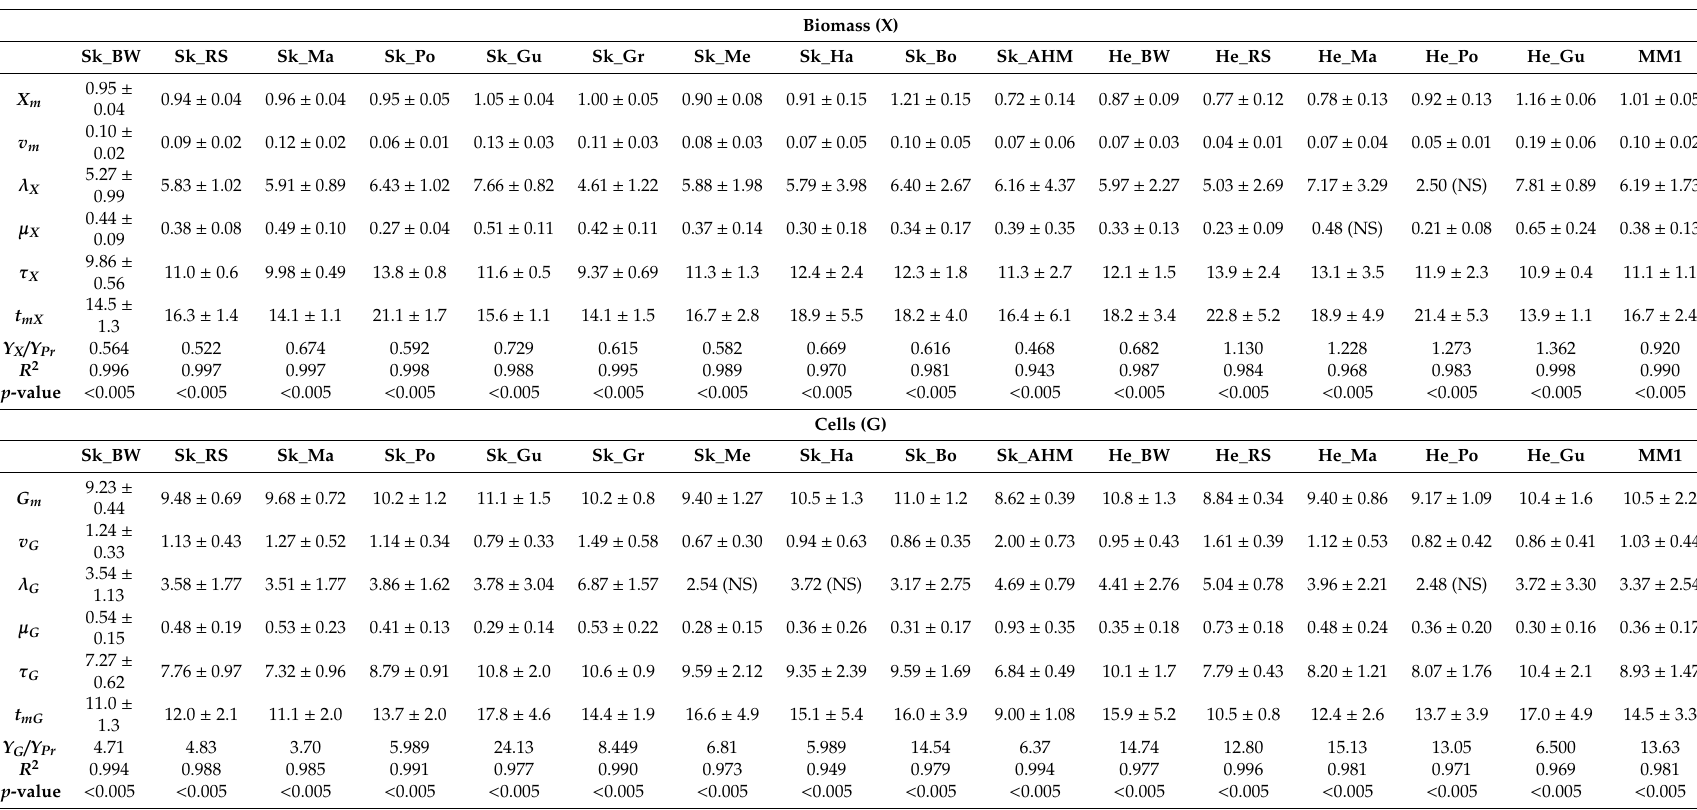
Table 1. Numerical values and confidence intervals for parameters obtained from experimental data of Phaeobacter sp. (Ph) growth modelled by a logistic equation (1-4). R 2 is the determination coe ffi cient among the experimental and predicted data. The production yields ( Y X / Y Pr and Y G / Y Pr ) are also shown. NS: not significant. MM1 and MM2 were the controls kinetics in commercial marine medium (MM) performed for each set of cultures. Consistency of fittings was also determined ( p -value from F-Fisher